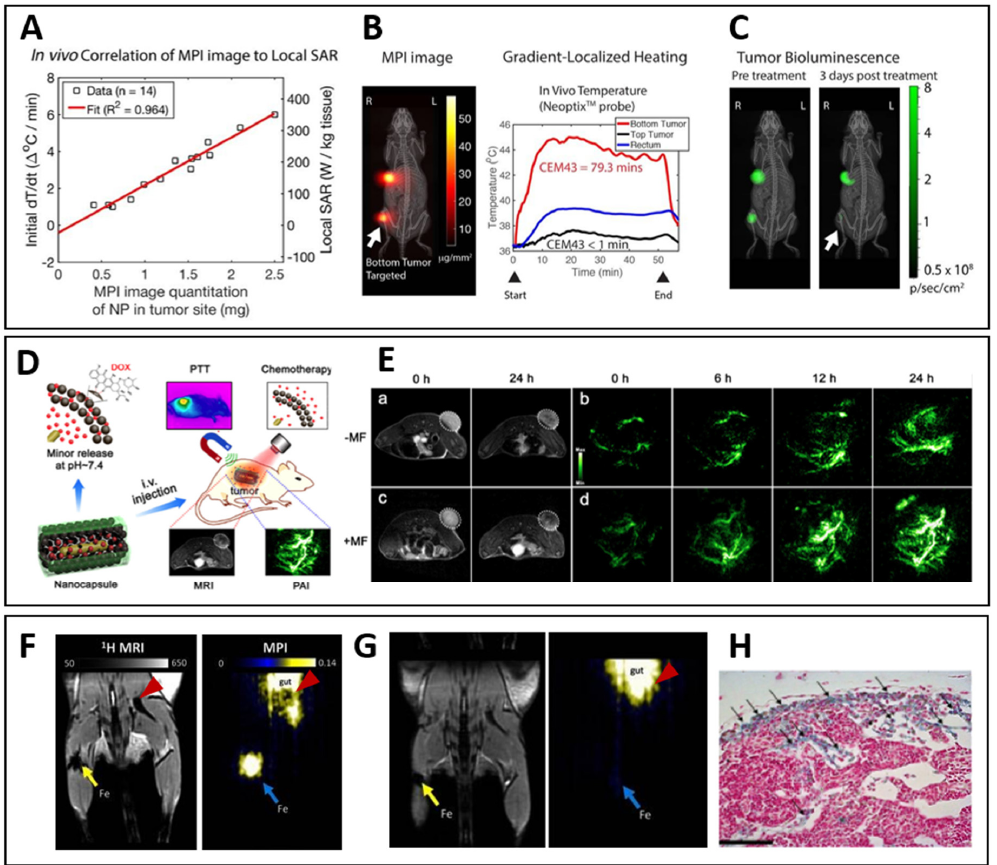
Figure 11. Imaging MCs in theranostic applications. ( A – C ) In vivo localized MPI guided MFH experiment. ( A ) MPI images provided quantitative information of SAR estimate at the tumor site, ( B ) MPI image of the dual tumor MDA-MB-231-luc xenograft mice. The bottom tumor is targeted